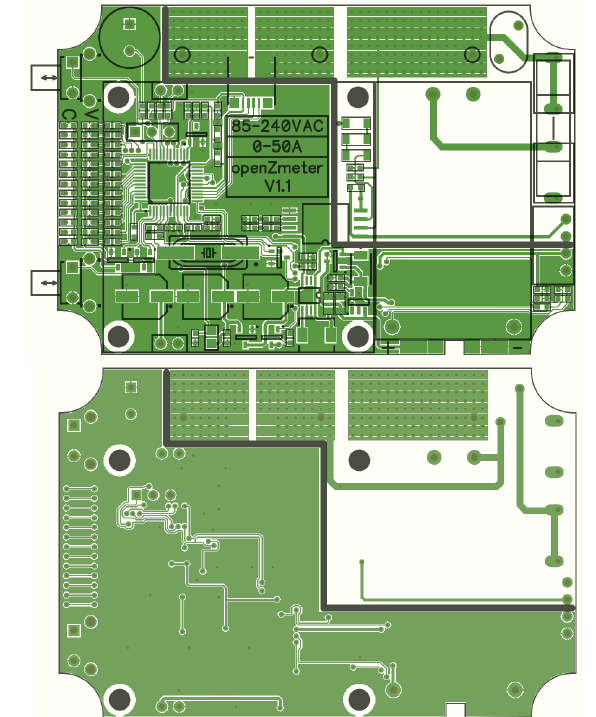
Figure 5. Printed circuit board (PCB) silkscreening of oZm